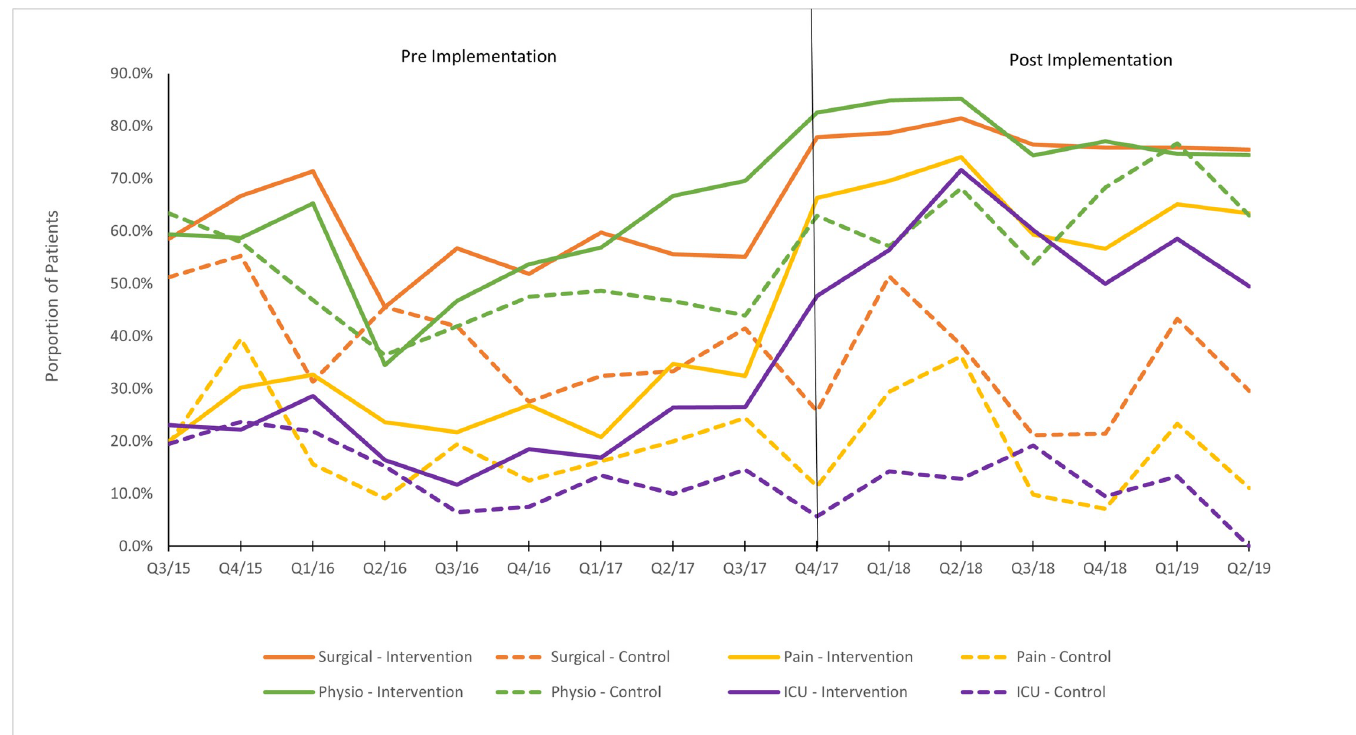
Fig 2. Reviews pre- and post- ChIP implementation by treatment groups [for all patients]–quarterly.